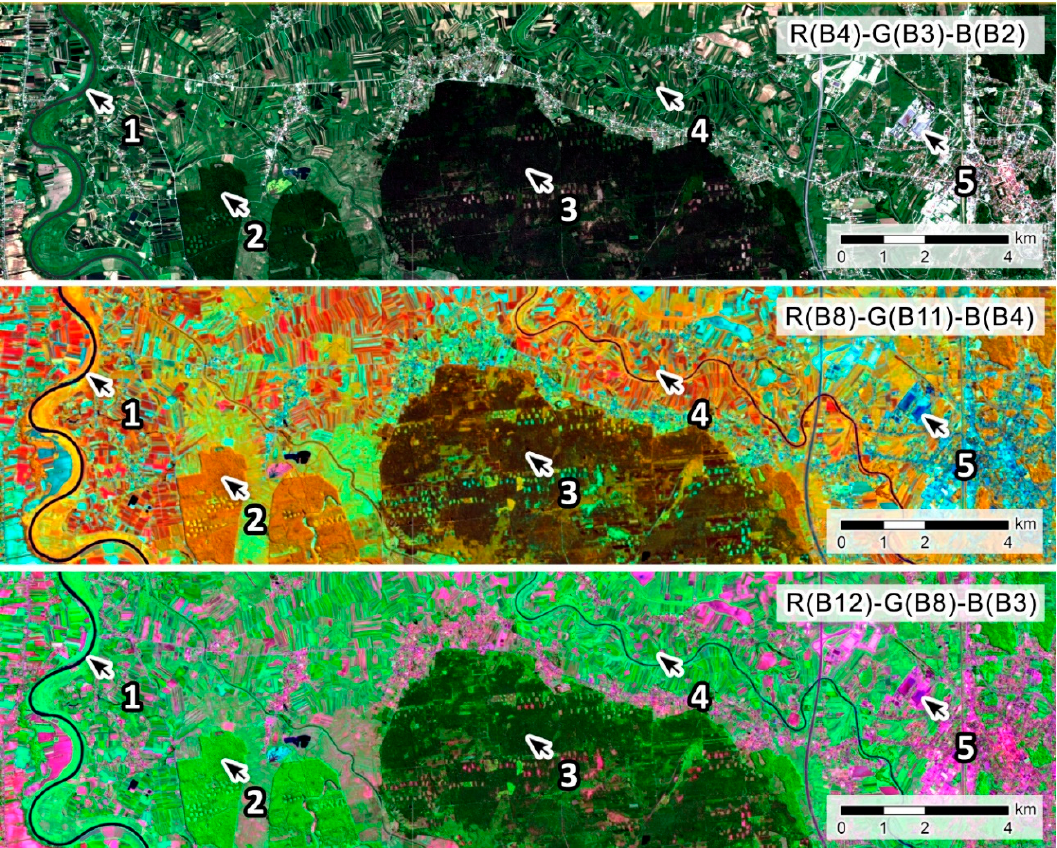
Figure 2. Five points that represent various land cover and land use classes on a satellite image of the same area, presented in three color band combinations. Satellite image acquired by Sentinel-2 at June